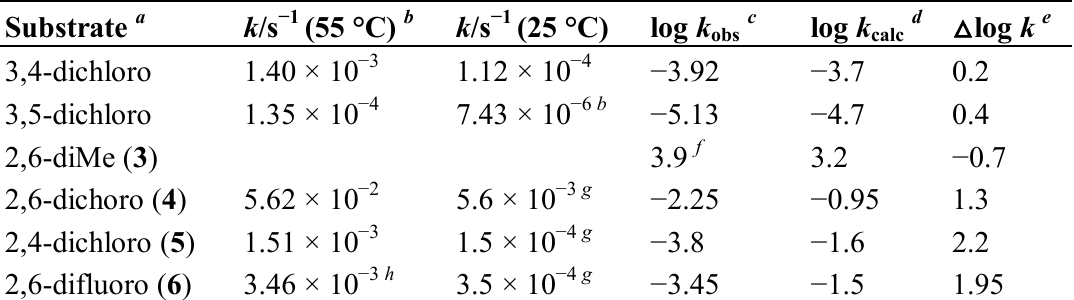
Table 5. Rate constants ( k ) and calculations of log k at 25 °C for benzoyl chlorides in 97% w/w hexafluoroisopropanol-water